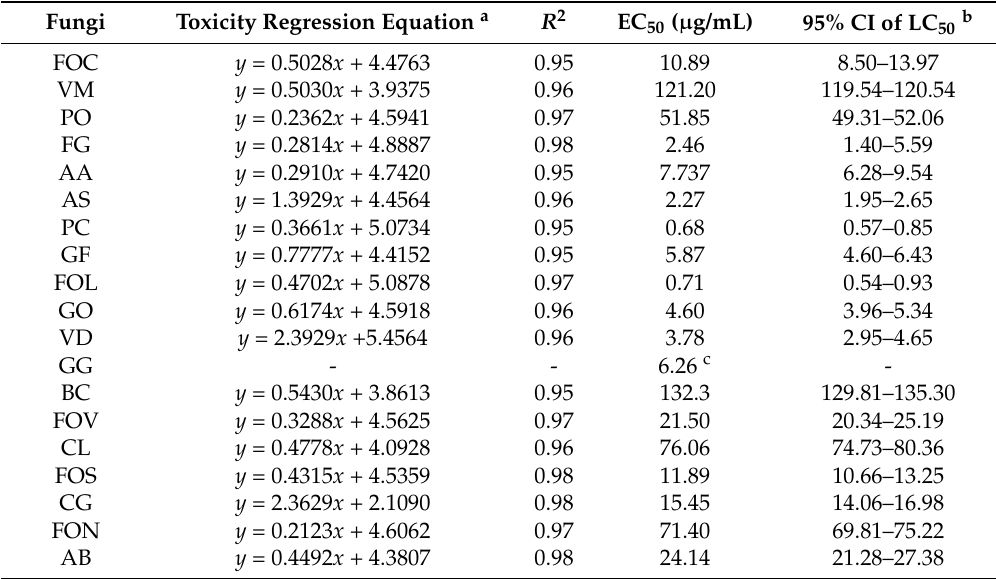
Table 4. Toxicity regression equations for concentration effect and EC 50 values of kresoxim-methyl against 19 strains of fungi.